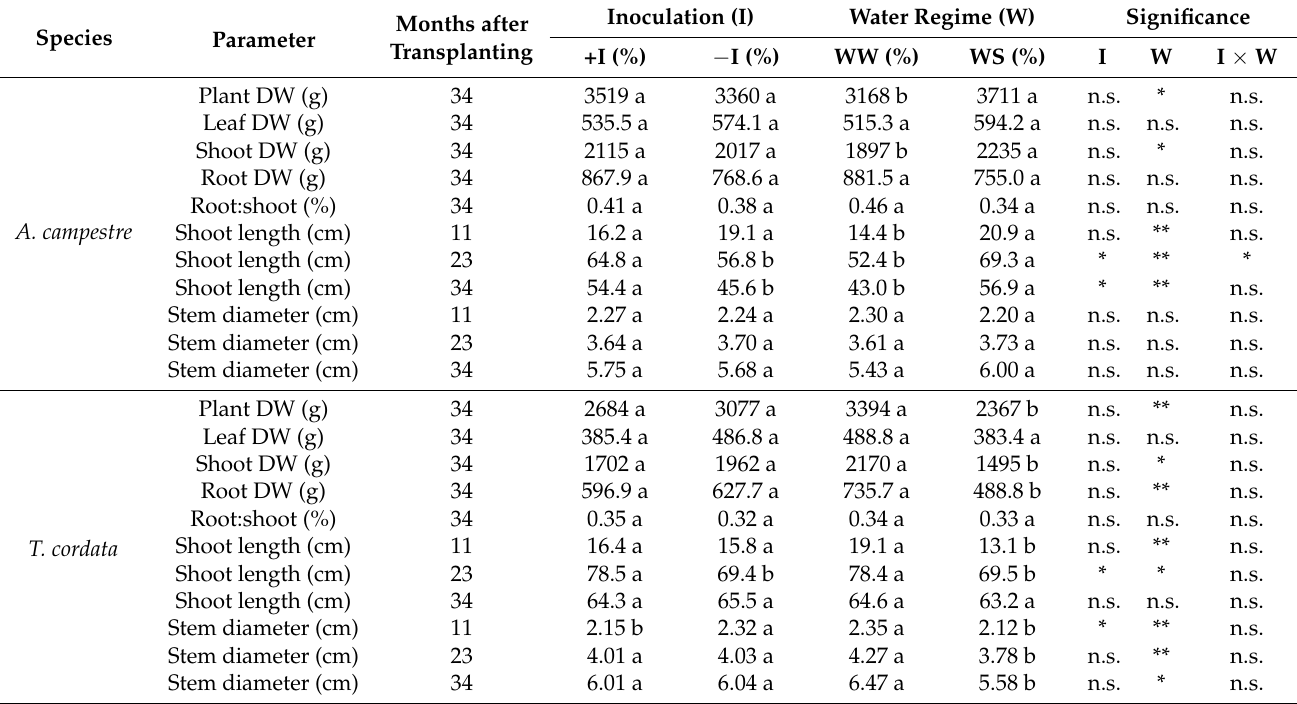
Table 2. Effect of nursery preconditioning techniques, i.e., mycorrhizal inoculation and water regime, and their interaction on total plant, leaf, shoot and root dry weight (DW), root:shoot, shoot length and diameter measured 11, 23 and 34 months after transplanting in Acer campestre L. and Tilia cordata